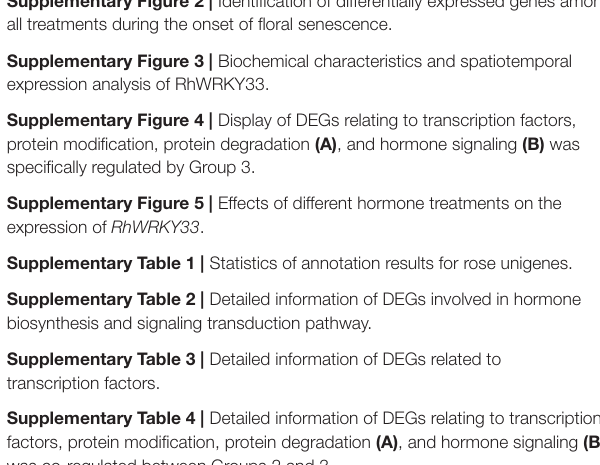
was specifically regulated by group 3. Supplementary Table 6 | List of primers